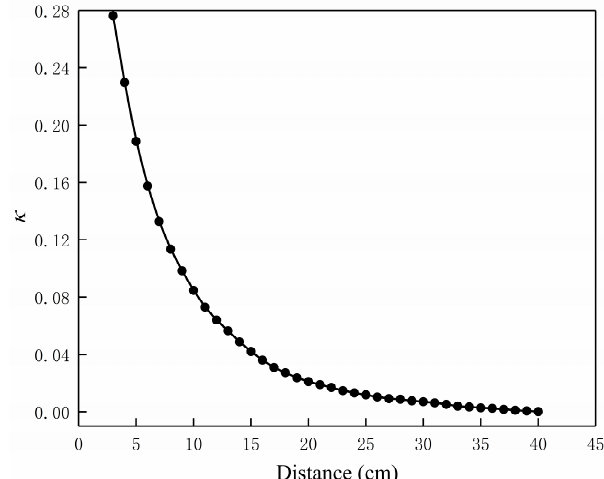
Figure 2. Coupling coefficient between the Tx and Rx coils versus the distance between them plotted using the experimentally obtained data.